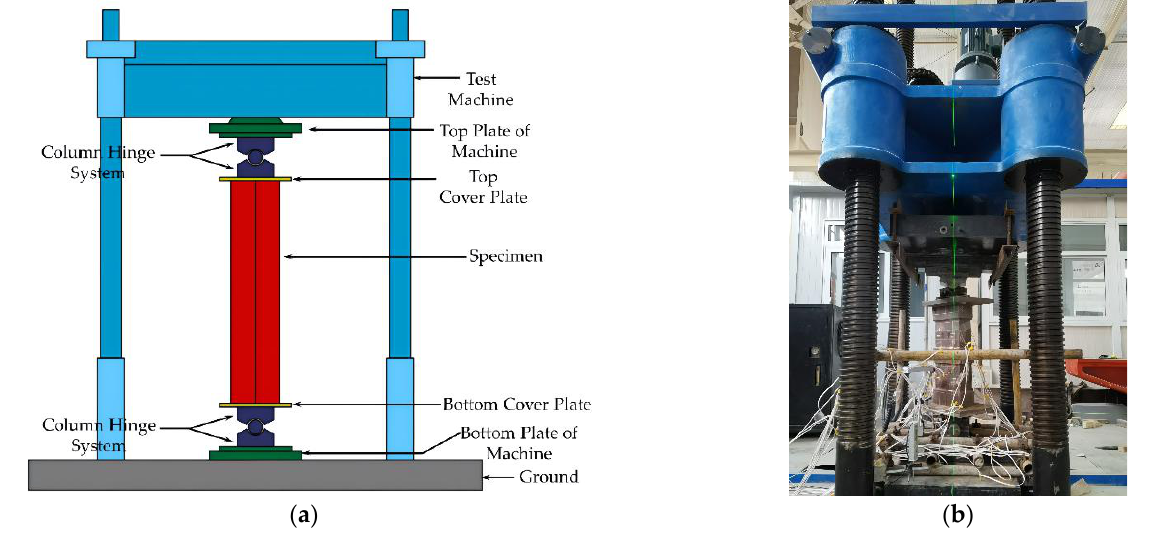
Figure 6. Test device ( a ) schematic diagram of loading device; ( b ) test photo. During the test, the load and longitudinal displacement data were obtained directly from the press. A linear variable displacement transducer was set in the middle of the column and at 1/4 of the height to measure the lateral deformation. Longitudinal and transverse strain gauges were applied to the tube’s surface to measure the strain. The layouts of the measuring device for the L- and T-shaped CFSST composite column with steel hoops are shown in Figure 7.